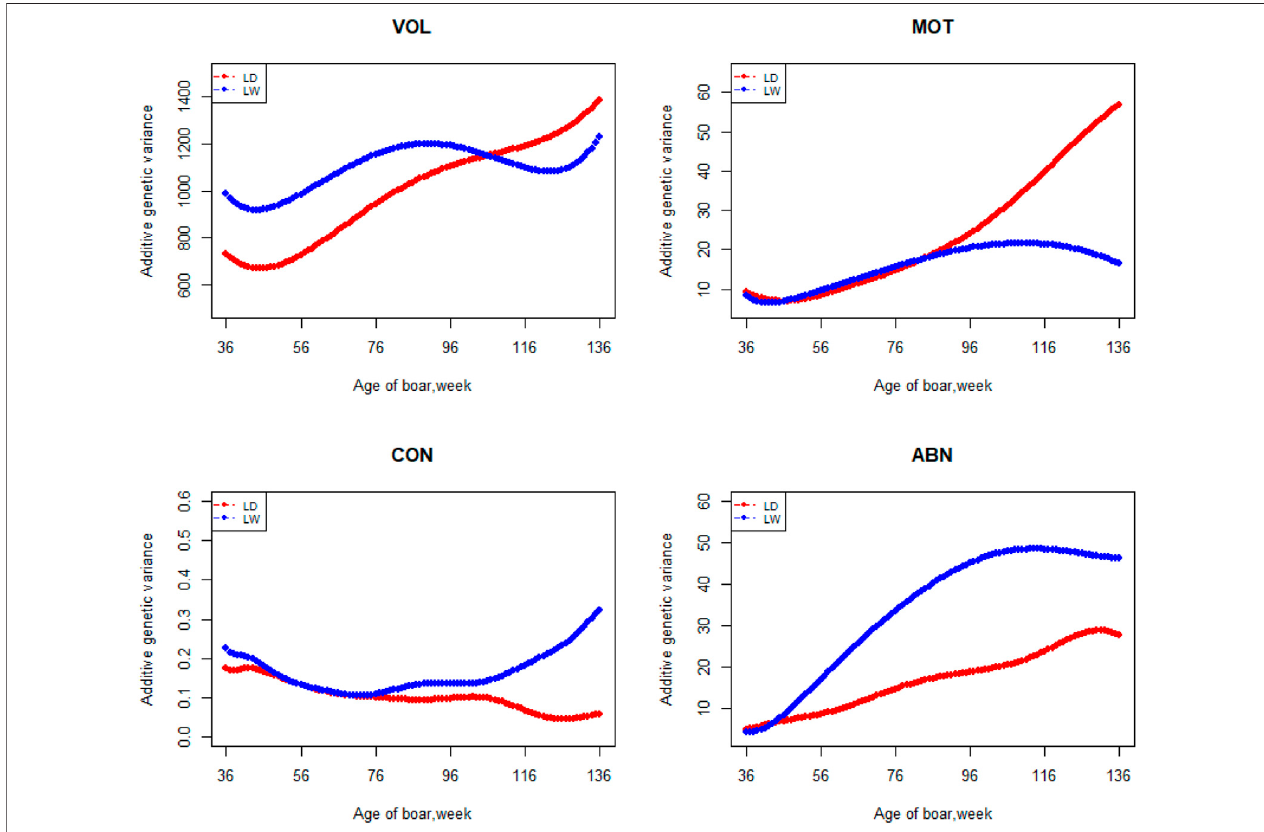
FIGURE 2 | Additive genetic variance from 36 weeks to the age of 136 weeks, estimated with a random regression animal model.